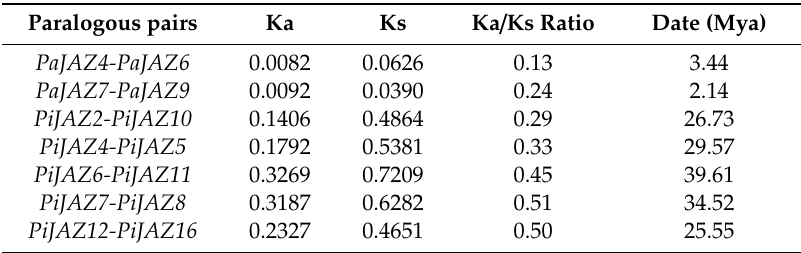
Table 2. Ks, Ka, and Ka / Ks ratios calculated for paralogous pairs of petunia JAZ genes. Paralogous pairs Ka Ks Ka / Ks Ratio Date